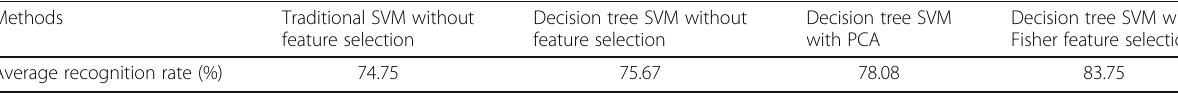
Table 4 Average recognition rate of three methods on CASIA